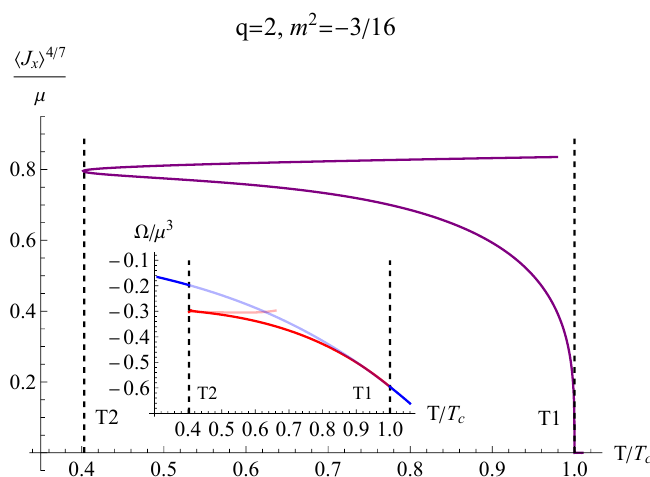
Figure 2 . Free energy density and phase transitions in the holographic p-wave superconductor model. The zeroth order phase transition occurs at T 2 = 0 . 4029 , with a critical temperature T c T c = 0 . 1487 . The inset plot is the free energy density of the zeroth-order phase transition. The red lines in the plot represent the superconducting states, while the blue line represents the normal state. Within the plot, only the solid lines indicate thermodynamic stability, whereas the lighter lines indicate thermodynamic instability. The second-order phase transition occurs at T 1 = 1 . T c